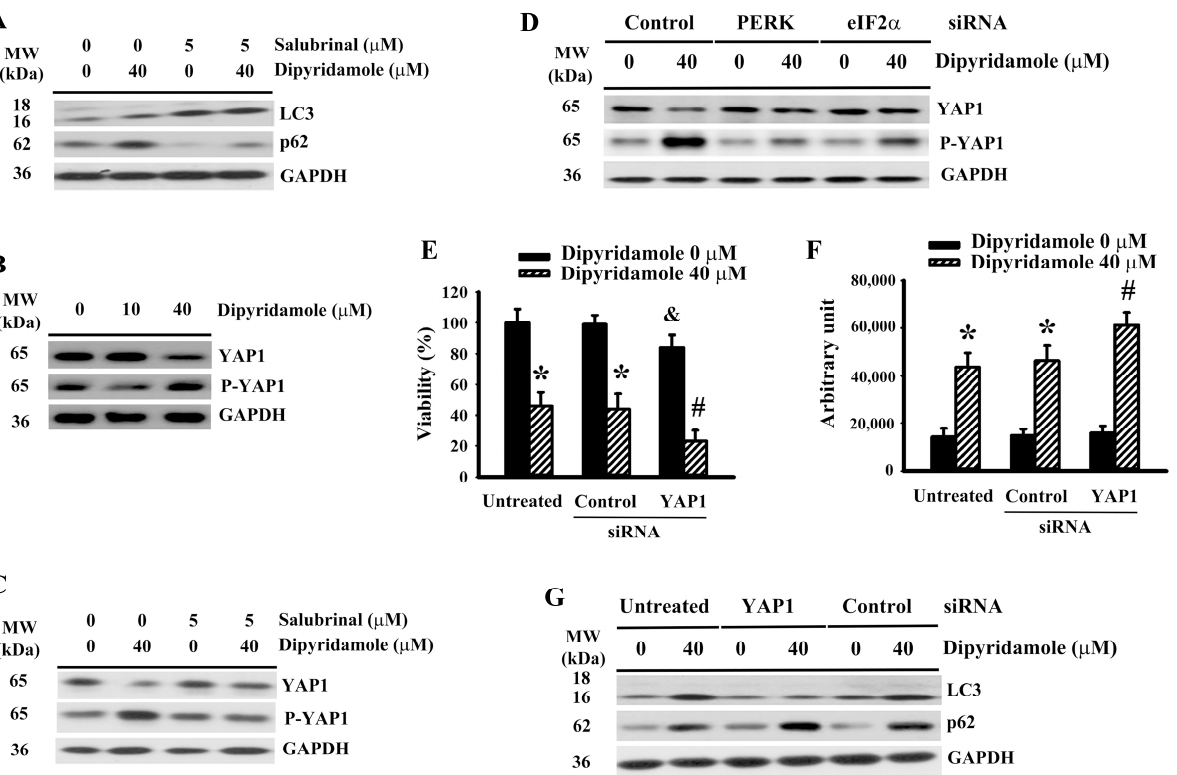
Figure 5. Dipyridamole increased YAP1 phosphorylation and decreased YAP1 content in U87 cells. ( A , C ) U87 cells were treated with dipyridamole (0 and 40 µ M) in the presence or absence of salubrinal (5 µ M) for 12 h. Proteins were determined using western blotting with indicated antibodies. Representative blots are shown. ( B ) U87 cells were treated with various concentrations of dipyridamole, as indicated for 12 h. Proteins were determined using western blotting with indicated antibodies. Representative blots are shown. ( D ) U87 cells were transfected with control siRNA, PERK siRNA, and eIF2 α siRNA for 24 h. The resultant transfected cells were treated with dipyridamole (0 and 40 μ M) for 12 h. Proteins were determined using western blotting with indicated antibodies. Representative blots are shown. U87 cells were transfected with control siRNA and YAP1 siRNA for 24 h. The resultant transfected cells were treated with dipyridamole (0 and 40 μ M). ( E ) Cell viability (24 h) was determined using MTS reduction assay. ( F ) Caspase 3 activity (12 h) was measured using an enzymatic assay. ( G ) Proteins (12 h) were determined using western blotting with indicated antibodies. Representative blots are shown. * p < 0.05 vs. untreated control, # p < 0.05 vs. dipyridamole (40 μ M) control, and & p < 0.05 vs. control siRNA/dipyridamole (0 μ M), n = 4.